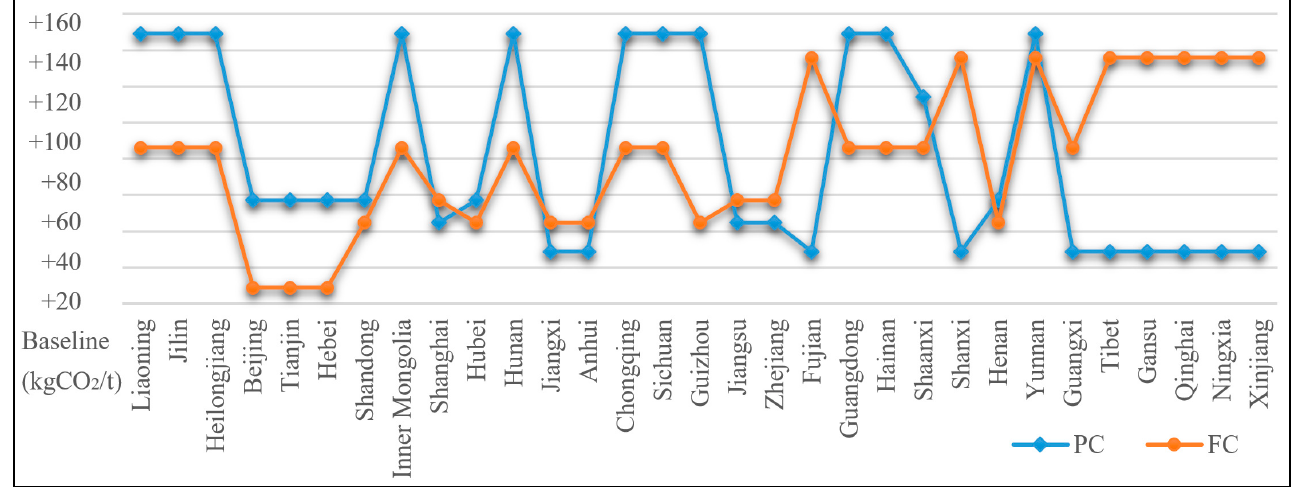
Figure 4. Difference of cement process carbon emission (PC) coefficient and fuel carbon emission coefficient (FC) between 31 provinces.